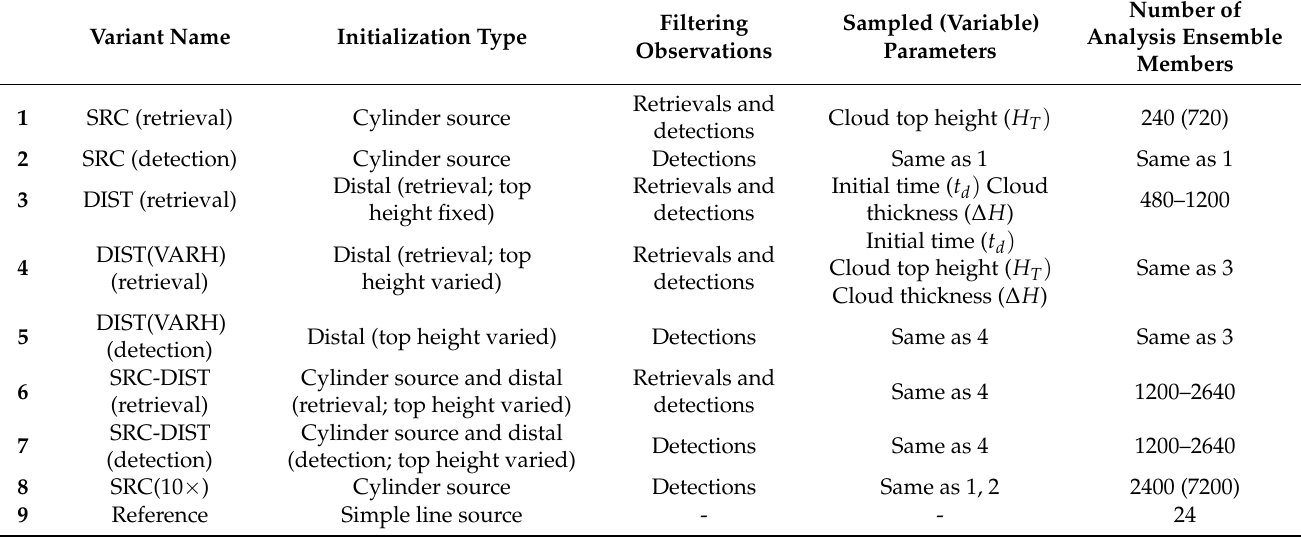
Table 1. A summary of the different model initialization methods (each associated with either satellite-based retrievals or detections), type of filtering observations, variable independent parameters, and the number of ensemble members used during the analysis phase in this study. The second number in brackets for the cylinder source in the last column indicates that more ensemble members were used in a few case studies. In these case studies, in which ash was released continuously over a period of several days, not only was the eruption height varied but so was the start time. This was done because the eruption start time was several days in the past relative to available observations and, therefore, it was not viable to start the simulation at the eruption start time. This approach is described in detail by Zidikheri et al.